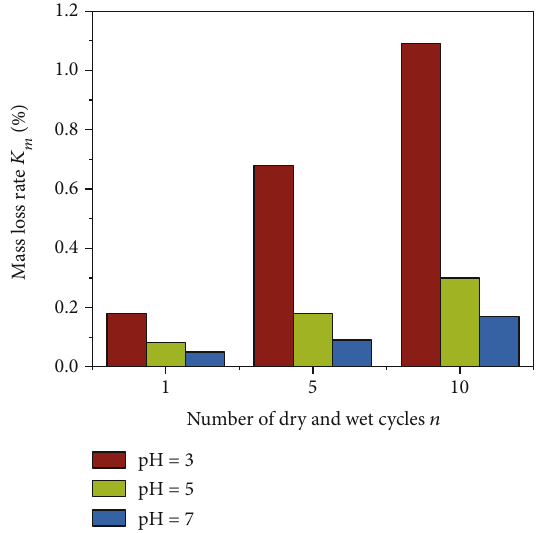
Figure 6: The relationship between mass loss rate and the number of dry-wet